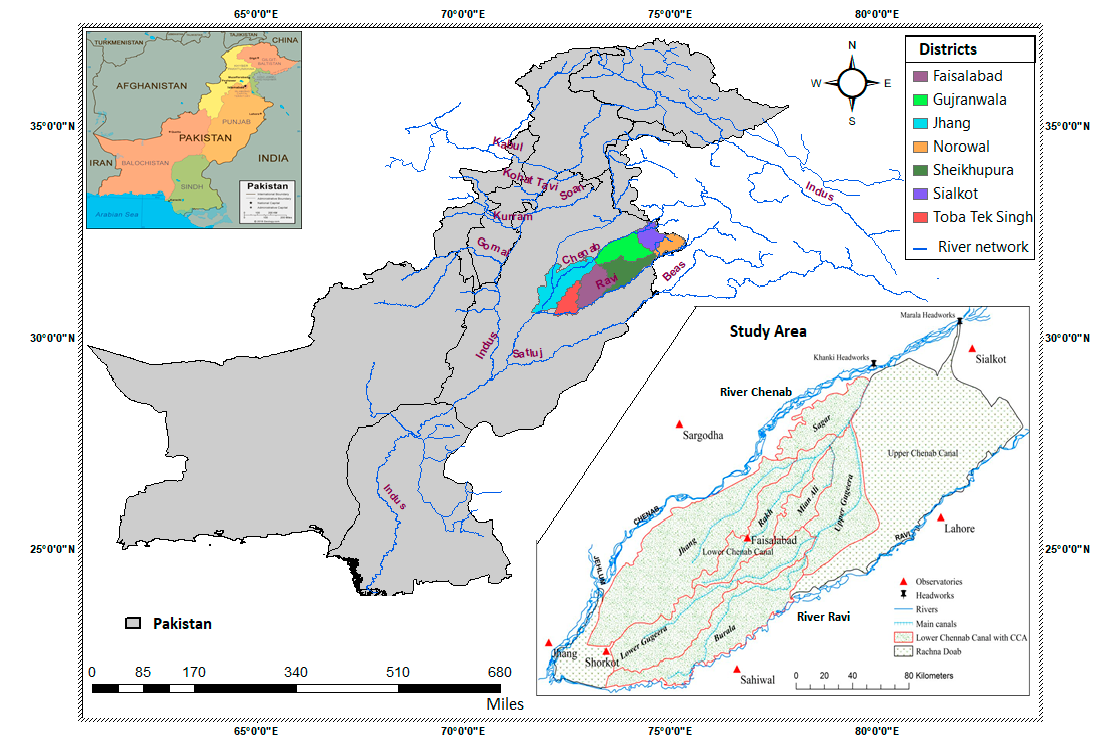
Figure 1. Map of Rechna Doab, Pakistan, configuration of irrigation network, irrigation districts, head-works, and metrological observatories located in the study area. Table 1. List of 26 NCEP (National Centers for Environmental Prediction) predictors used in this study.